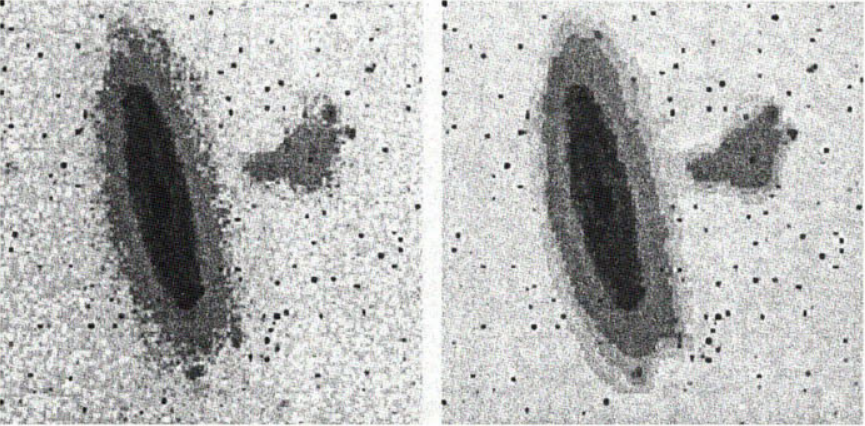
Fig. 1. A combined image of 074-2237 (left panel) and the image after adaptive filtering (right panel). Intensity cutoffs of the images in WFPC2 intensity counts are 0 (lower) and 210